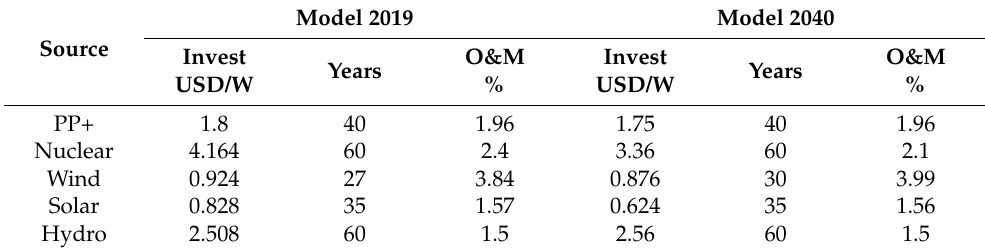
Table 7. The used cost parameters in EnergyPLAN.